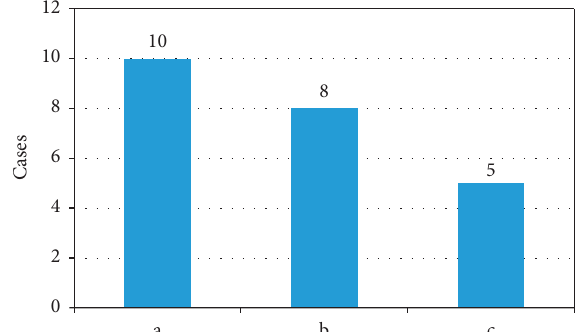
Figure 5: Analysis results of functional core nodes of the whole brain network in two groups. (a) Te specifc network core node of patient group; (b) the network core node unique to control group; and (c) the network core nodes shared by both